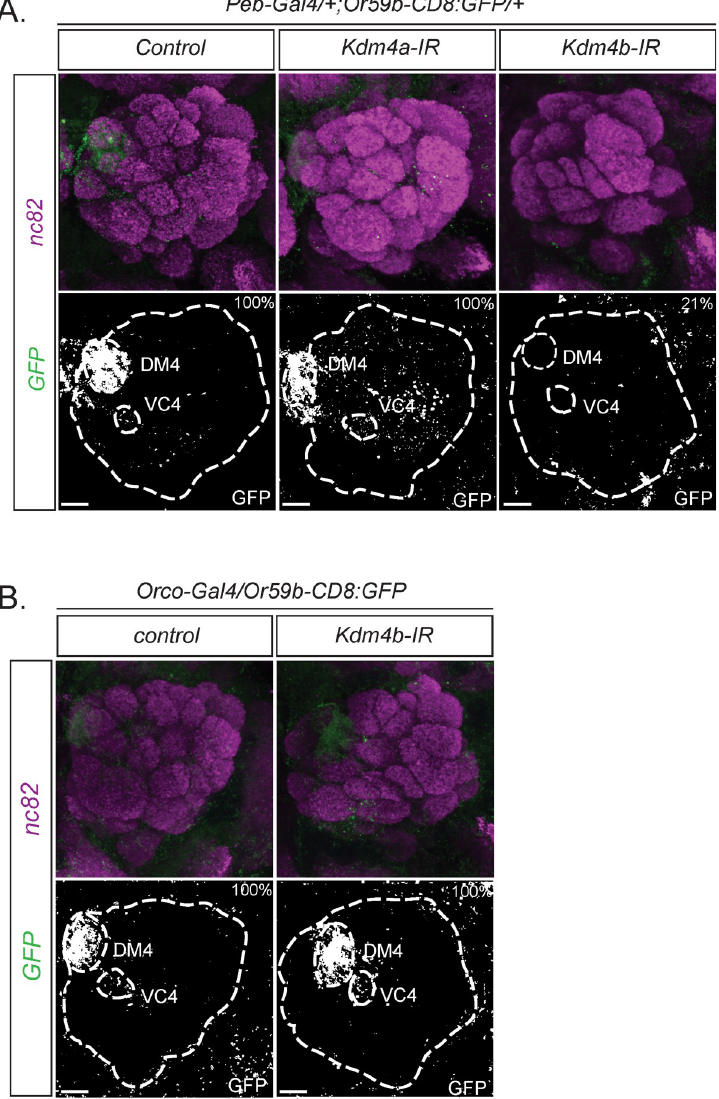
Fig 5. Kdm4b initiates Or59b expression. Whole-mount brain staining shows Or59b reporter expression of GFP (green). Synaptic neuropil regions are labeled with the presynaptic marker nc82 (magenta). Scale bar denotes 3.5 μ m. (A) Loss of expression of the Or59b reporter is observed in the knock-down of Kdm4b but not Kdm4a . Control flies were crossed to w 1118 . (B) Orco-Gal4 knock-down of Kdm4b after the initiation of odorant receptor expression. Percentage denotes the proportion of flies with the depicted phenotype. Control flies were crossed to w 1118 (S2